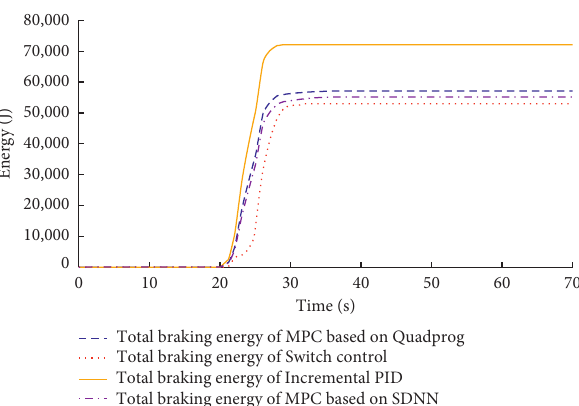
Figure 14: Total braking energy of four controllers.